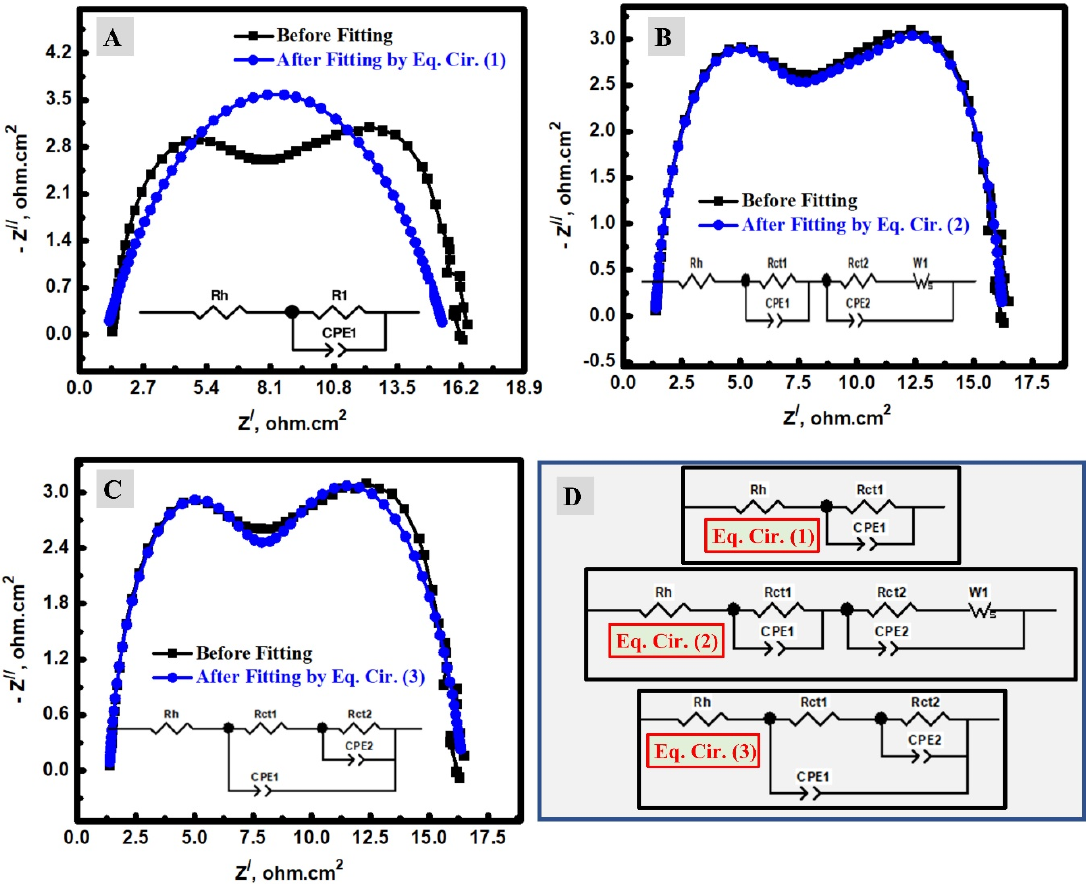
Figure 5. EIS analyses of DSCs using the prepared TiO 2 NFs, including experimental data and their